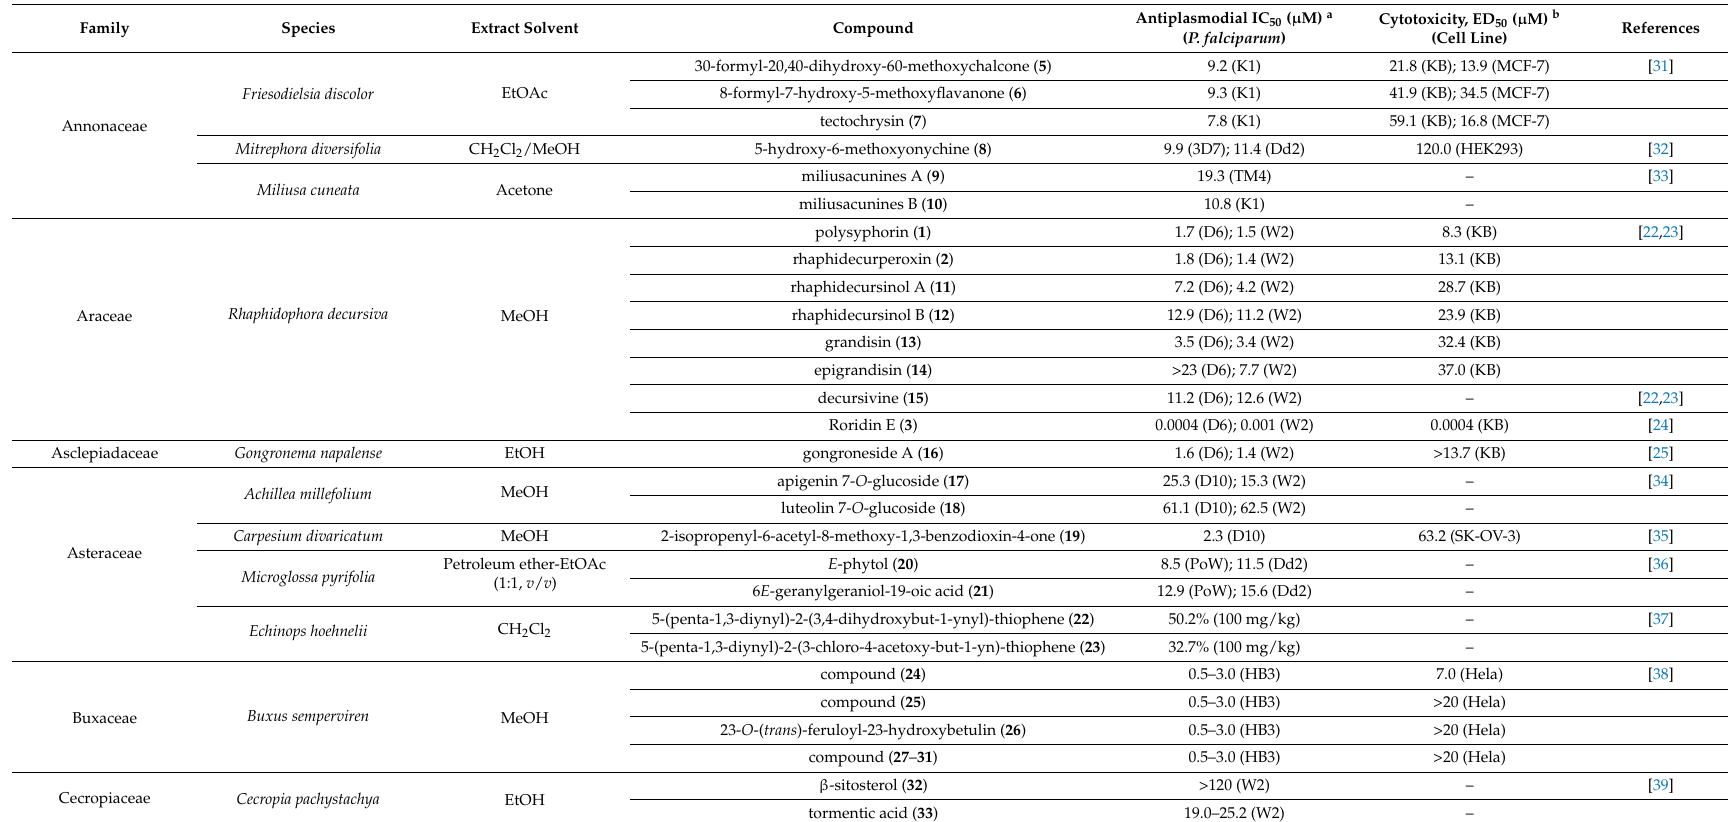
Table 2. Antiplasmodial activities and toxicities of compounds isolated from terrestrial